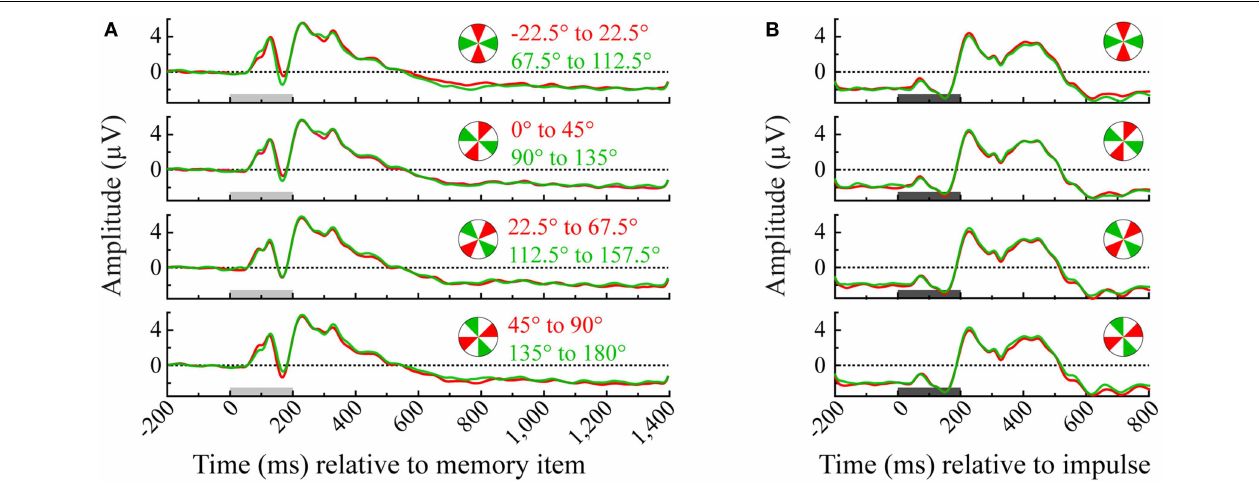
FIGURE 2 | Event-related potentials of each angle bin averaged over the occipital channels (O1, Oz, and O2). Illustrated are all pairwise orthogonal angle bin comparisons that were made in the multivariate analysis of the memory item epoch (A) and impulse epoch (B) . Light-gray and dark-gray bars represent the presentation of memory item and impulse stimuli,